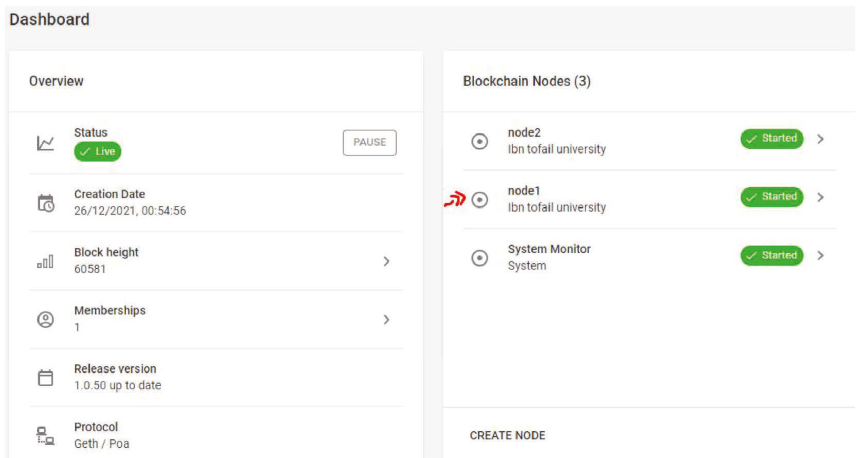
Figure 7: Implementing the smart contracts on node 1.